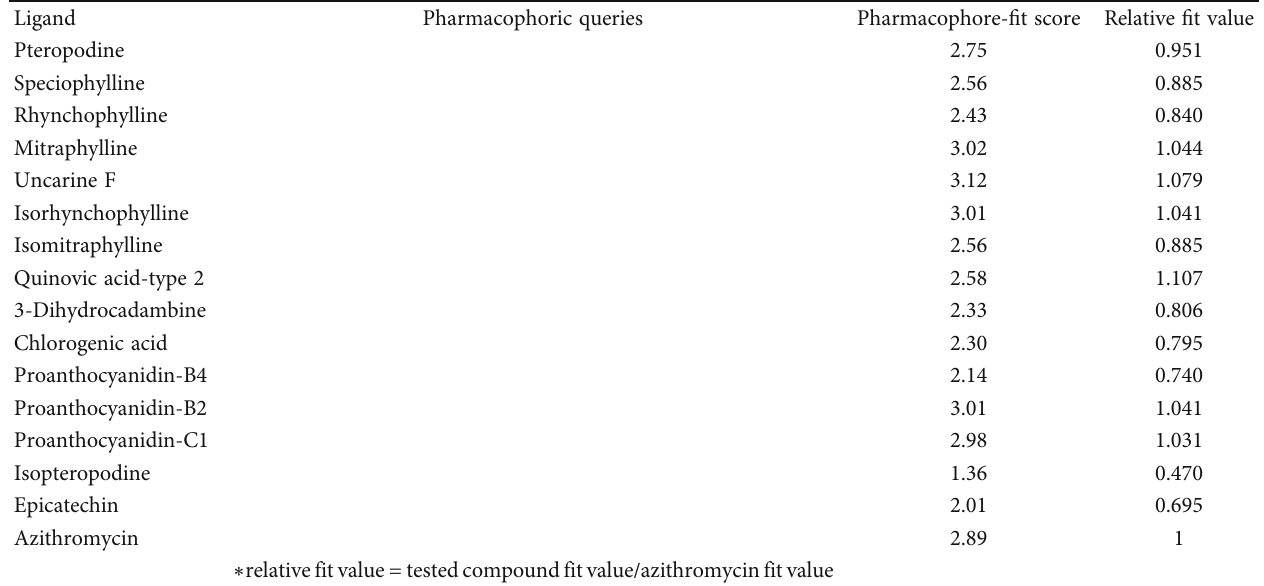
Figure 1: Schematic structure of the SARS-CoV-2 Omicron spike protein attached with host ACE2. Table 1: Essential features, fi t values, and relative fi t values of the tested ligands and Azithromycin based on the generated pharmacophore